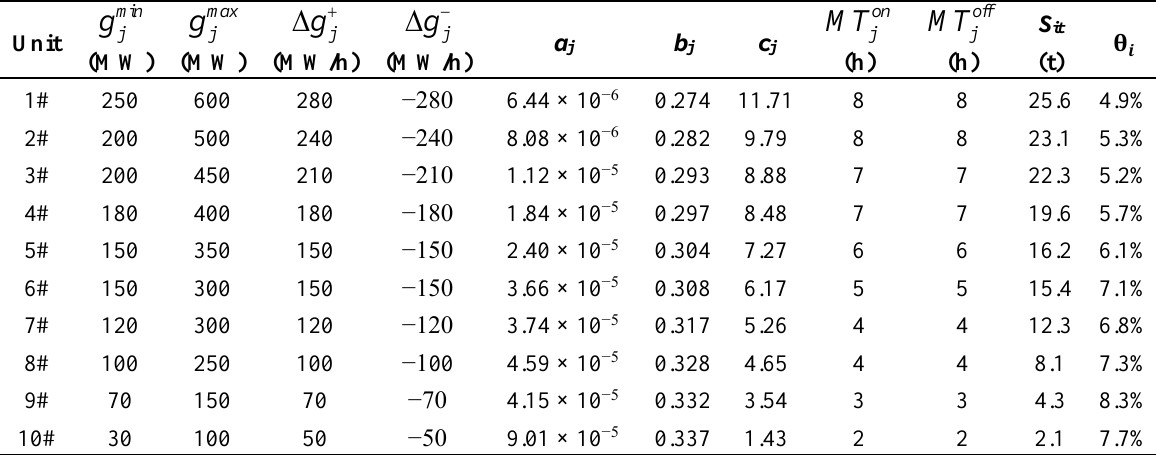
Table 1. Coefficients of thermal power